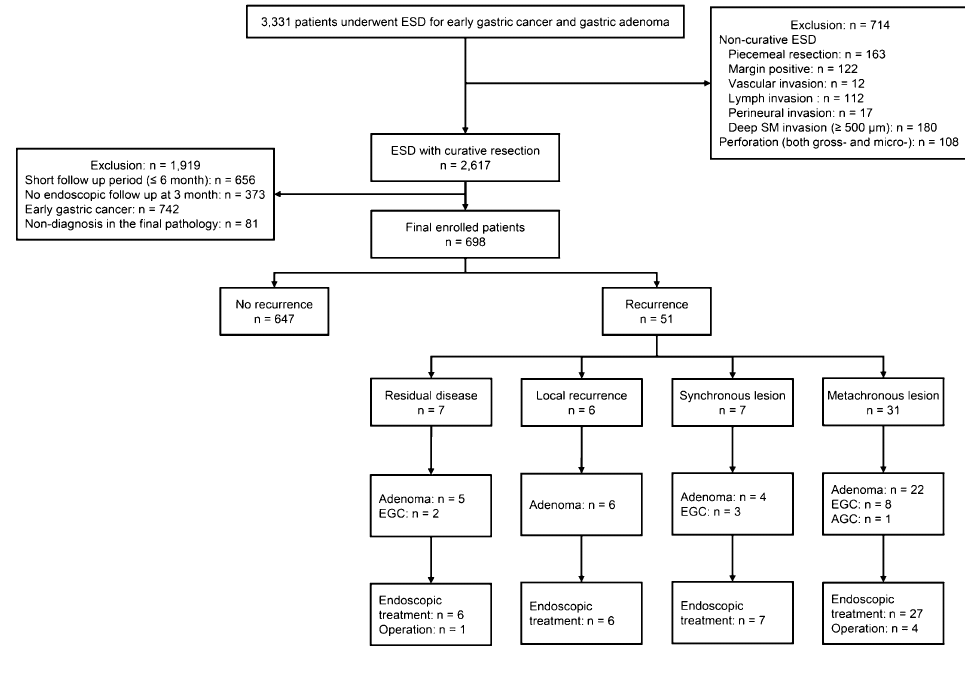
Figure 1. Flow diagram of enrolled